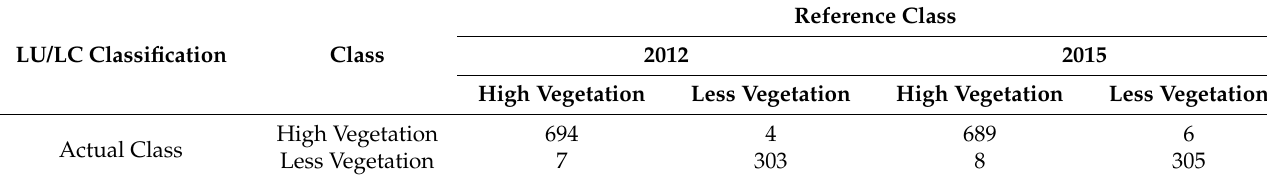
Table 6. LU/LC confusion matrix.